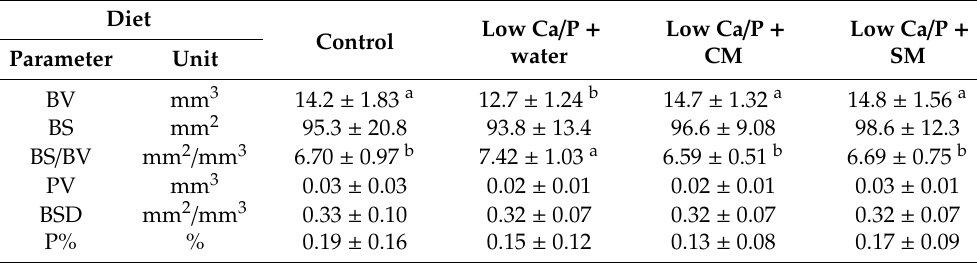
Table 3. Cortical bone characteristics of femora from rats fed di ff erent milk